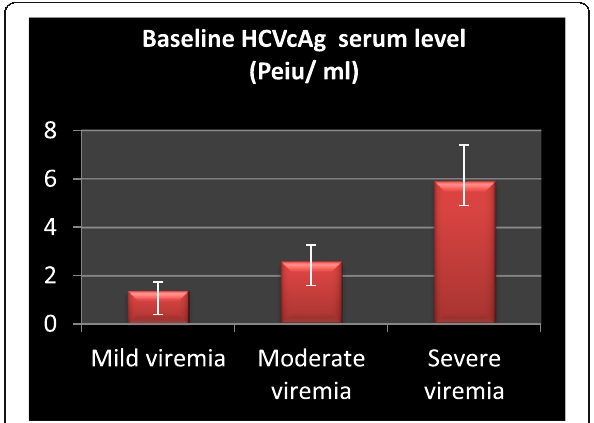
Fig. 2 Baseline HCVcAg levels (Peiu/mL)